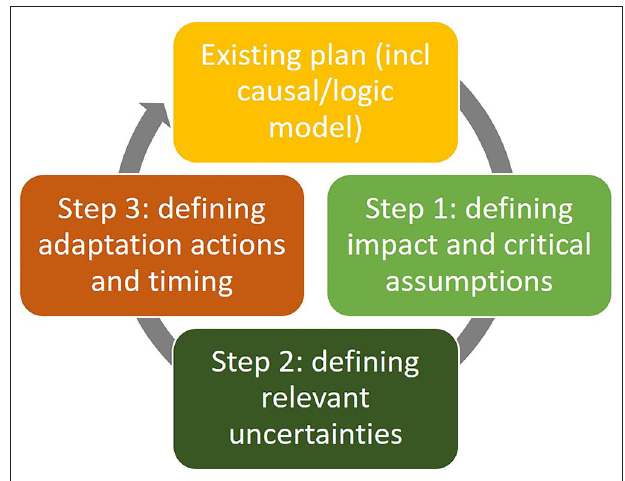
FIGURE 1 | Three additional adaptive planning